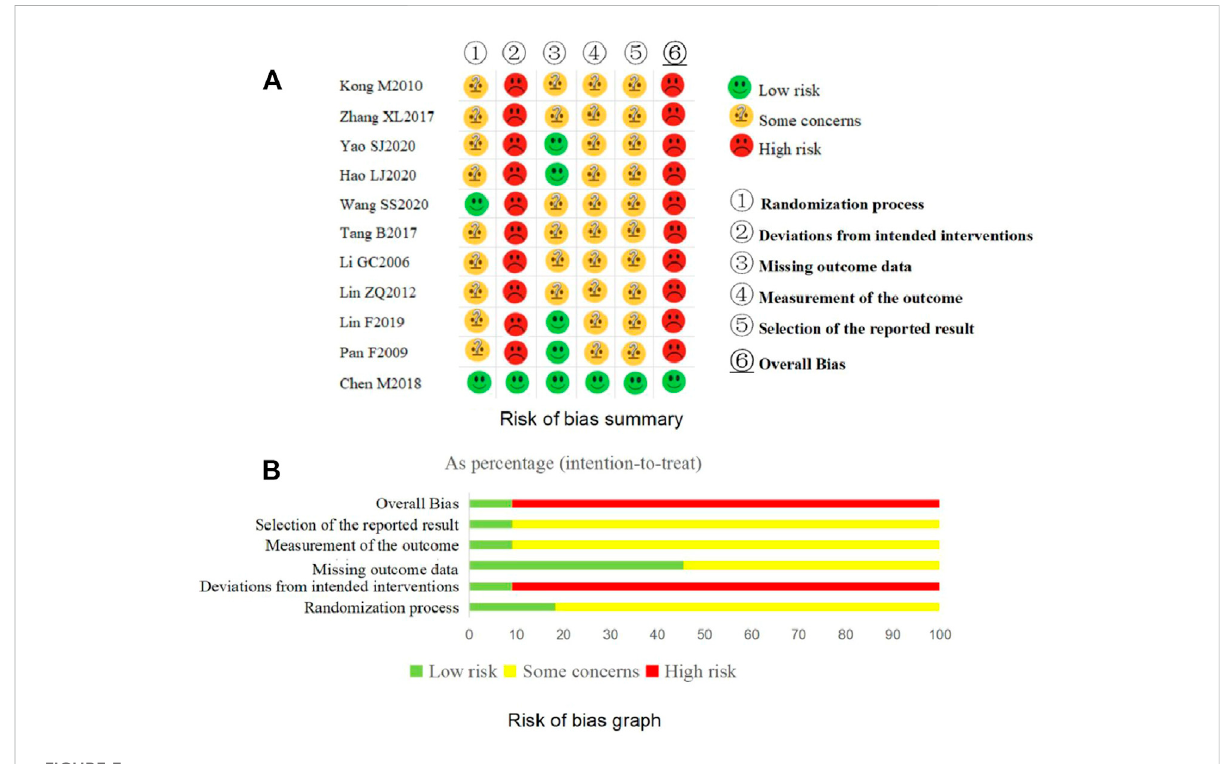
FIGURE 3 Risk of bias of the included 11 randomized controlled